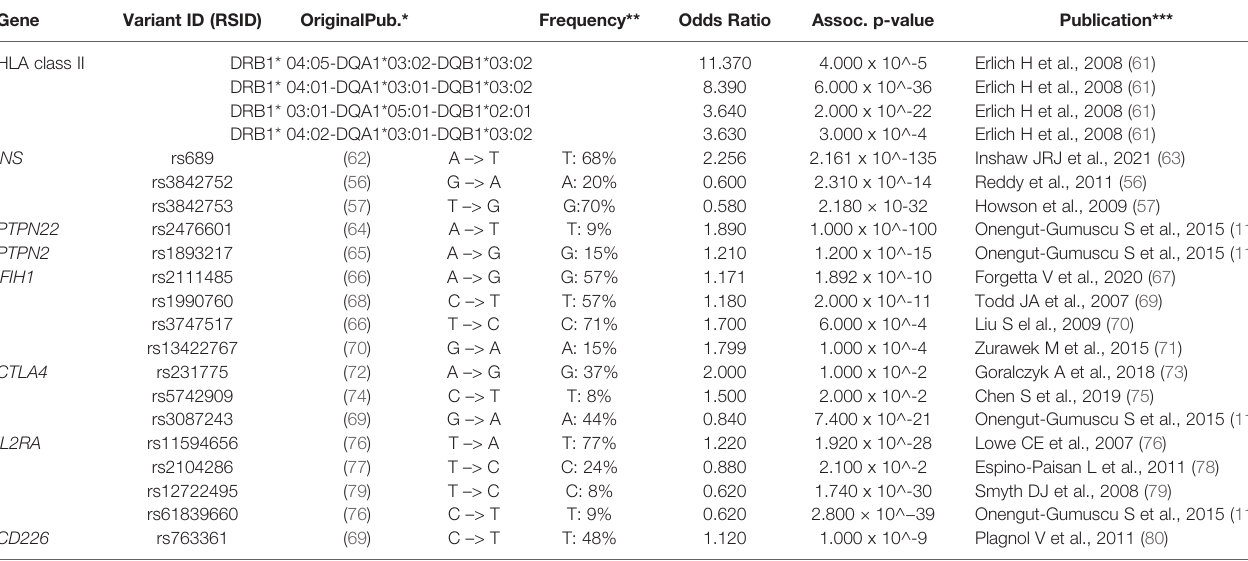
TABLE 1 | Risk gene variants associated with T1D (discussed in this review). For each gene variant the variant ID, risk allele frequency and odd ratio are